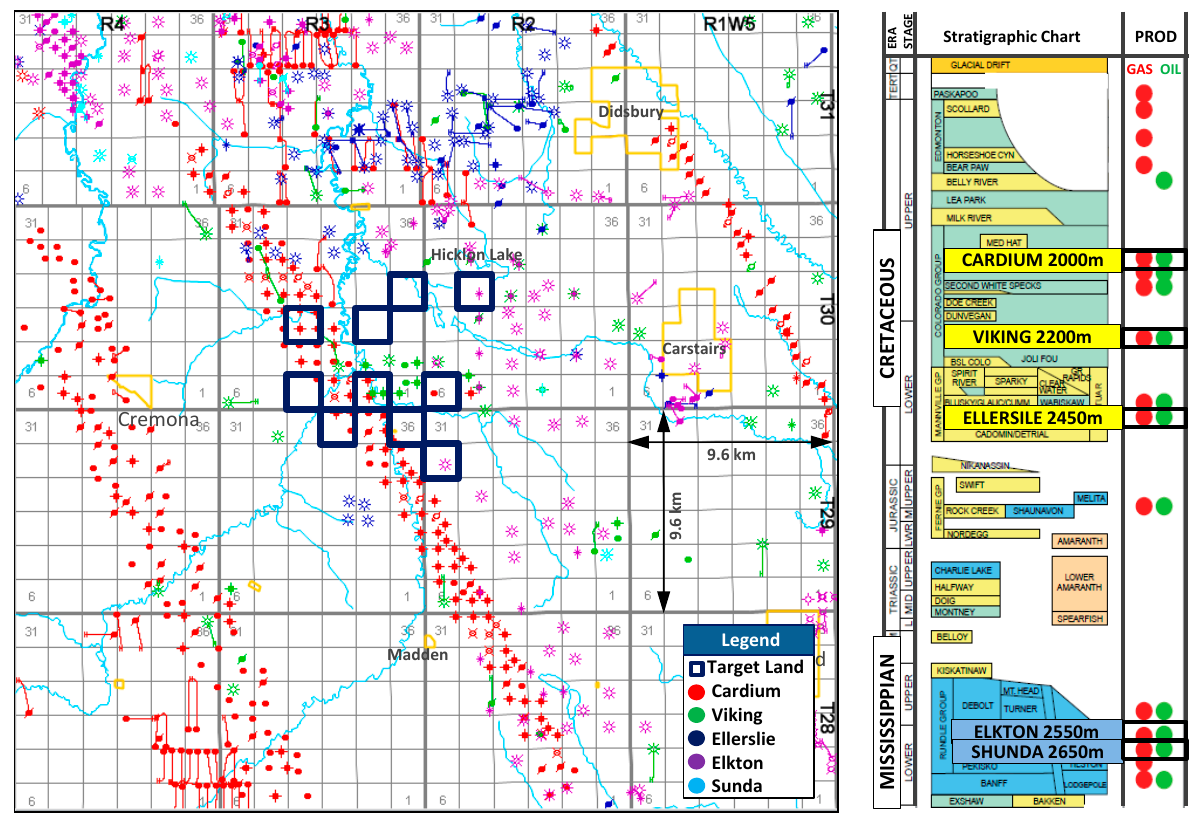
Figure 2. Multi-zone oil and gas producers in the study area.